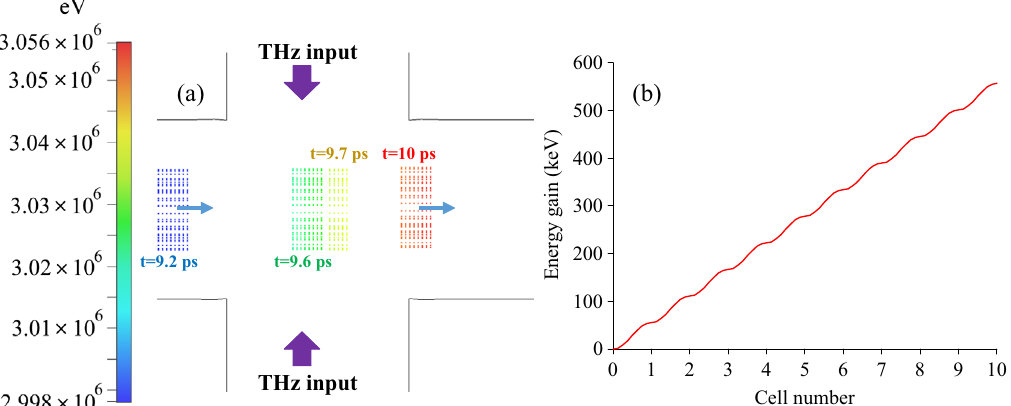
FIG. 11. Bunch acceleration in the structure: (a) Bunch acceleration for sequent time frames. (b) Cumulative energy gain along the beam path.